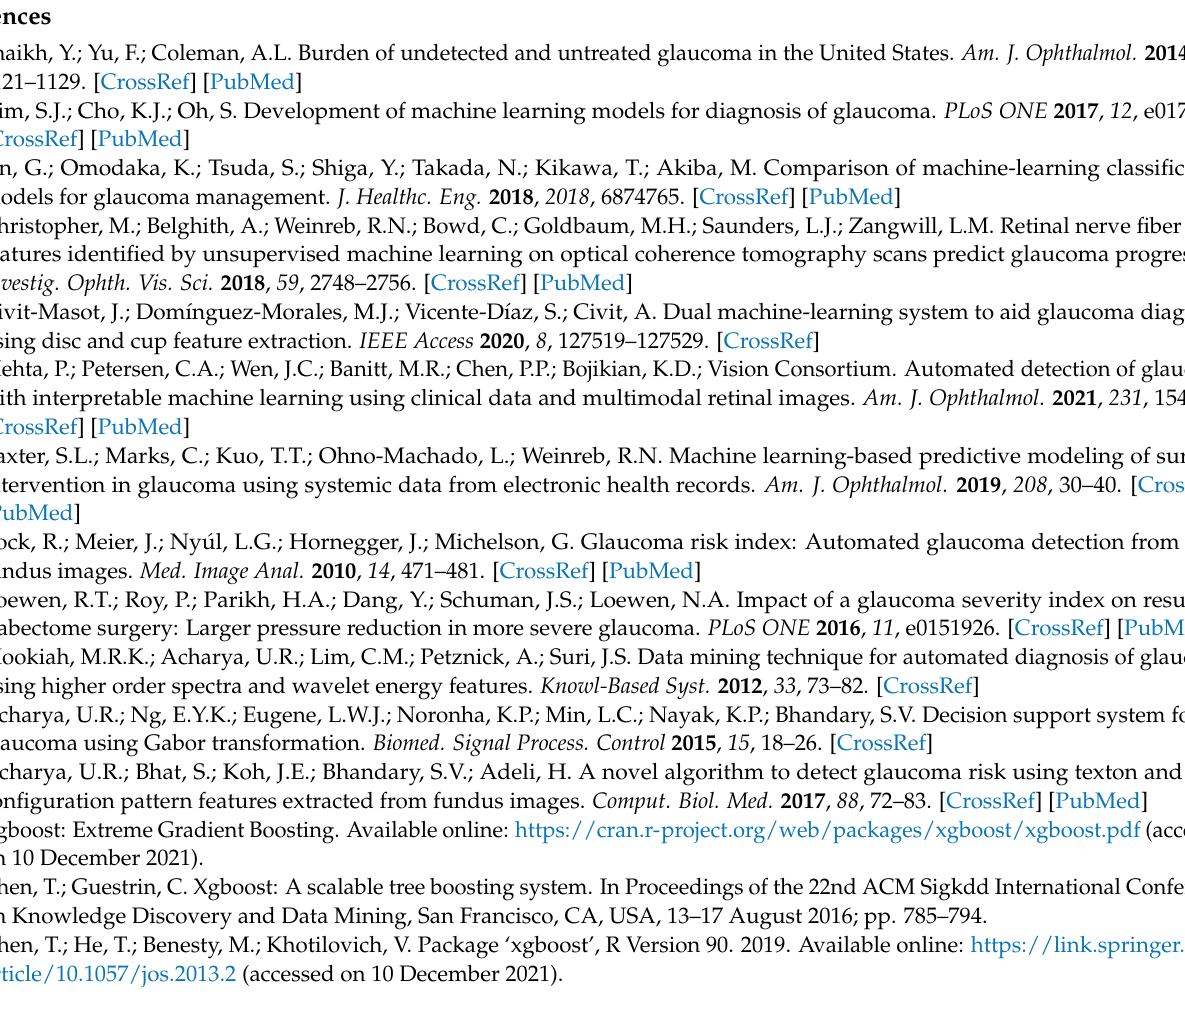
Figure A1. Screenshot of the I-GRI